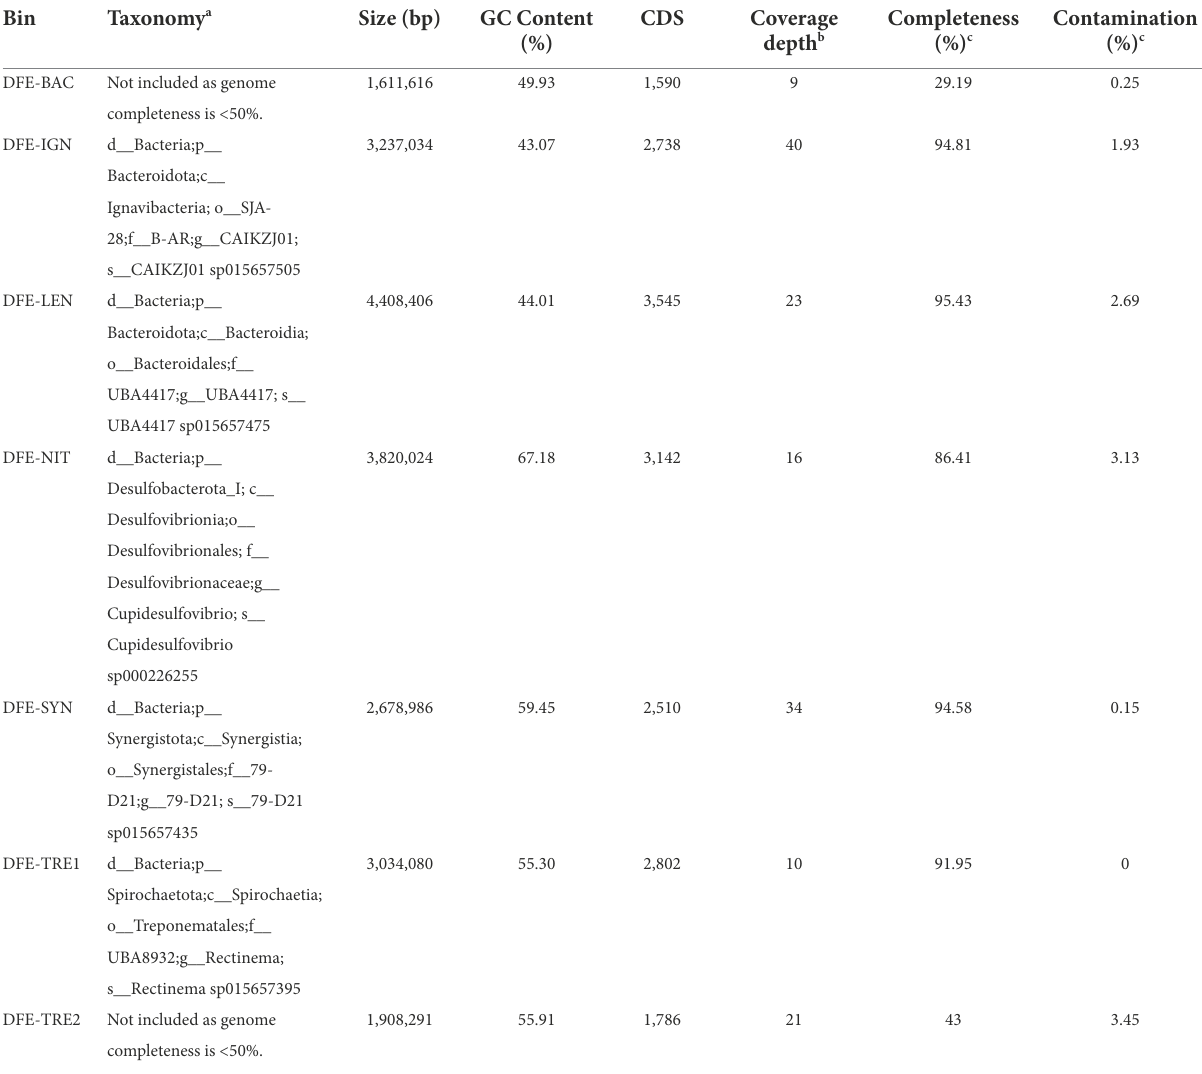
TABLE 1 Overview of the MAGs assembled from the DFE culture metagenome. Bin Taxonomy